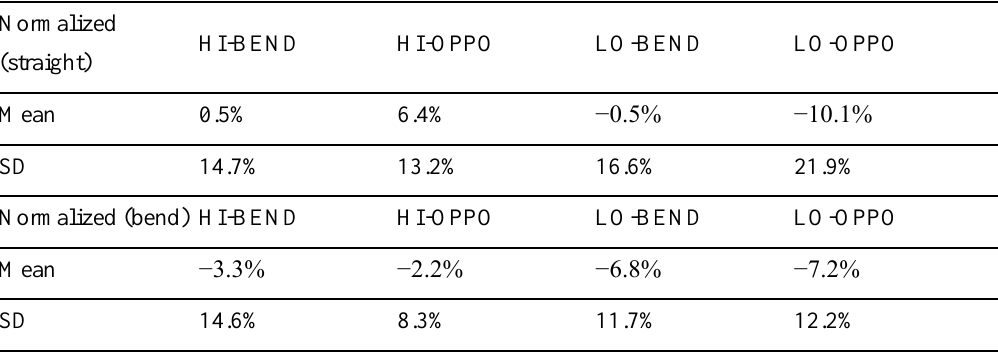
Table 2. Detection rate changes and standard deviations for the different target locations in straights and